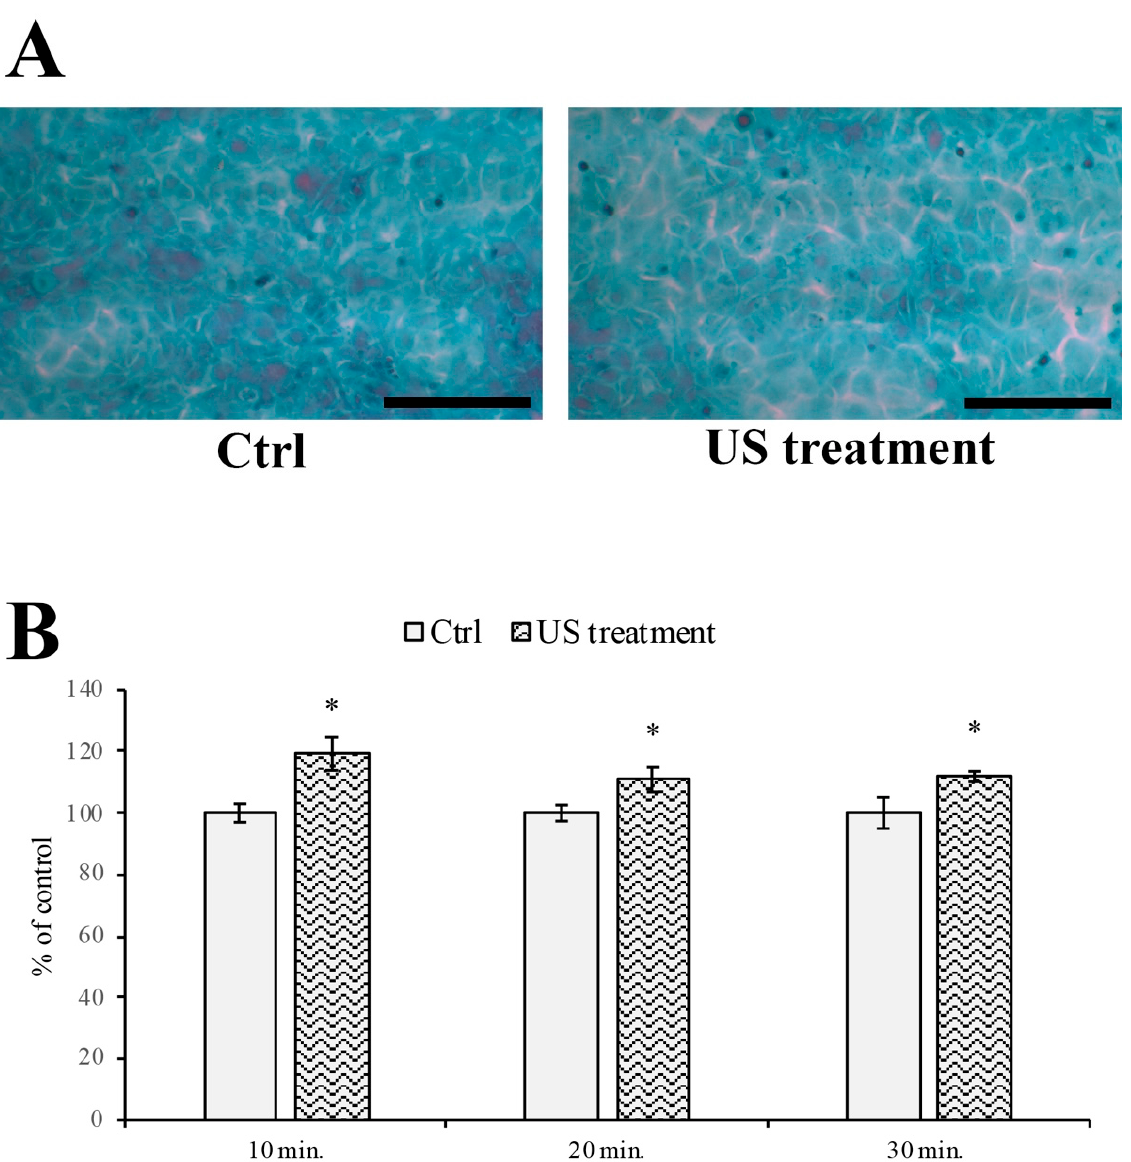
Figure 5. Intercellular spaces analysis on RBE4 monolayer during US treatment. ( A ) Representative illustrations showing the RBE4 monolayer treated with Papanicolaou staining, in both natural condition and after US stimulation. ( B ) Histograms showing the width of the intercellular gaps after US treatment for 10, 20, and 30 min. The results are expressed as the mean ± S.E.M. of three independent experiments, performed in triplicate. Five microscopic fields per experimental point were taken and analyzed. The control (untreated cells) were arbitrarily taken as 100%. Total magnification 200 × ; scale bar: 100 µ m; * p ≤ 0.05 vs. control (untreated cells).